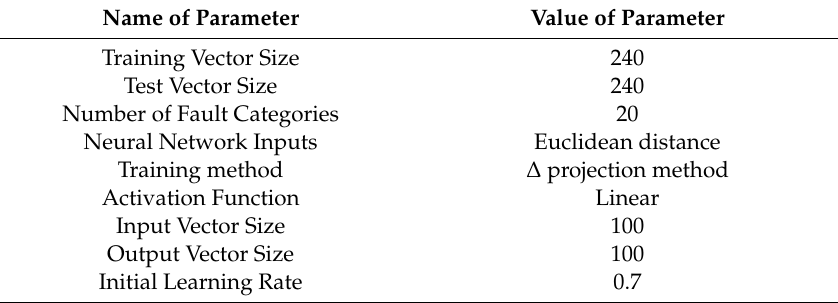
Table 7. Parameters of the RHN network and training process.